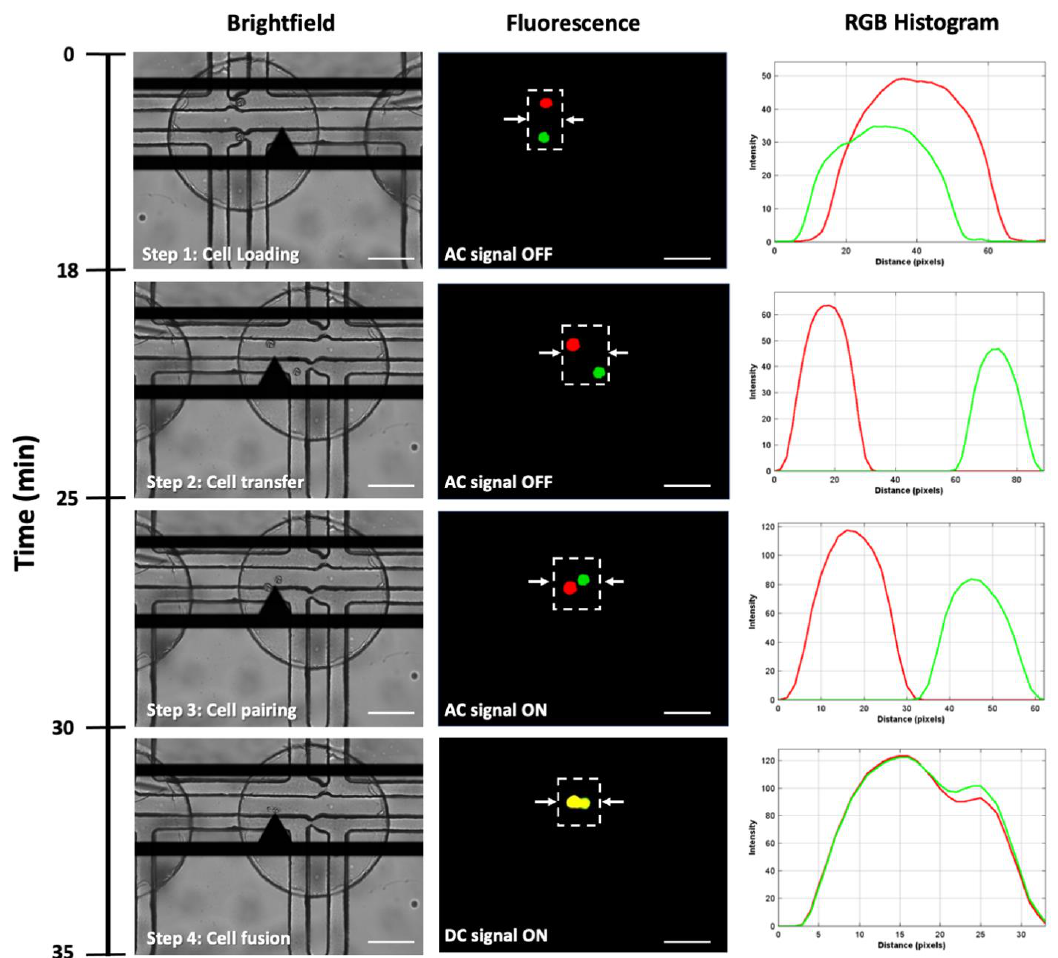
Figure 4. A magnified image sequence for cell electrofusion process along with brightfield image, fluorescence image, and RGB histogram. Step 1: Cell loading process with trapped THP-1 and A549 cells. Step 2: Transfer of cells into the fusion well by flipping the MFC. Step 3: Cell – cell contact is achieved by applying AC electric field. Step 4: After applying the DC pulse, the color of the fused cell changed to yellow. The RGB histogram represents the position and respective color of cells. The white arrows in the fluorescence images indicate the region across which the histogram is plotted. Scale bar: 50 µm.